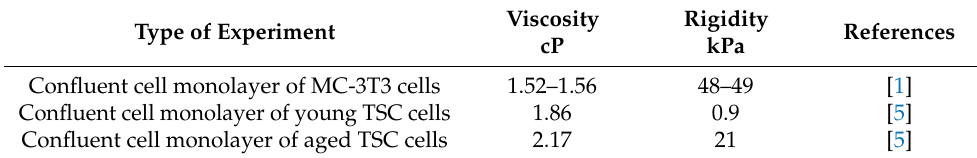
Table 1. Estimated properties for cell monolayers with QCM by Fang Li and Wu.